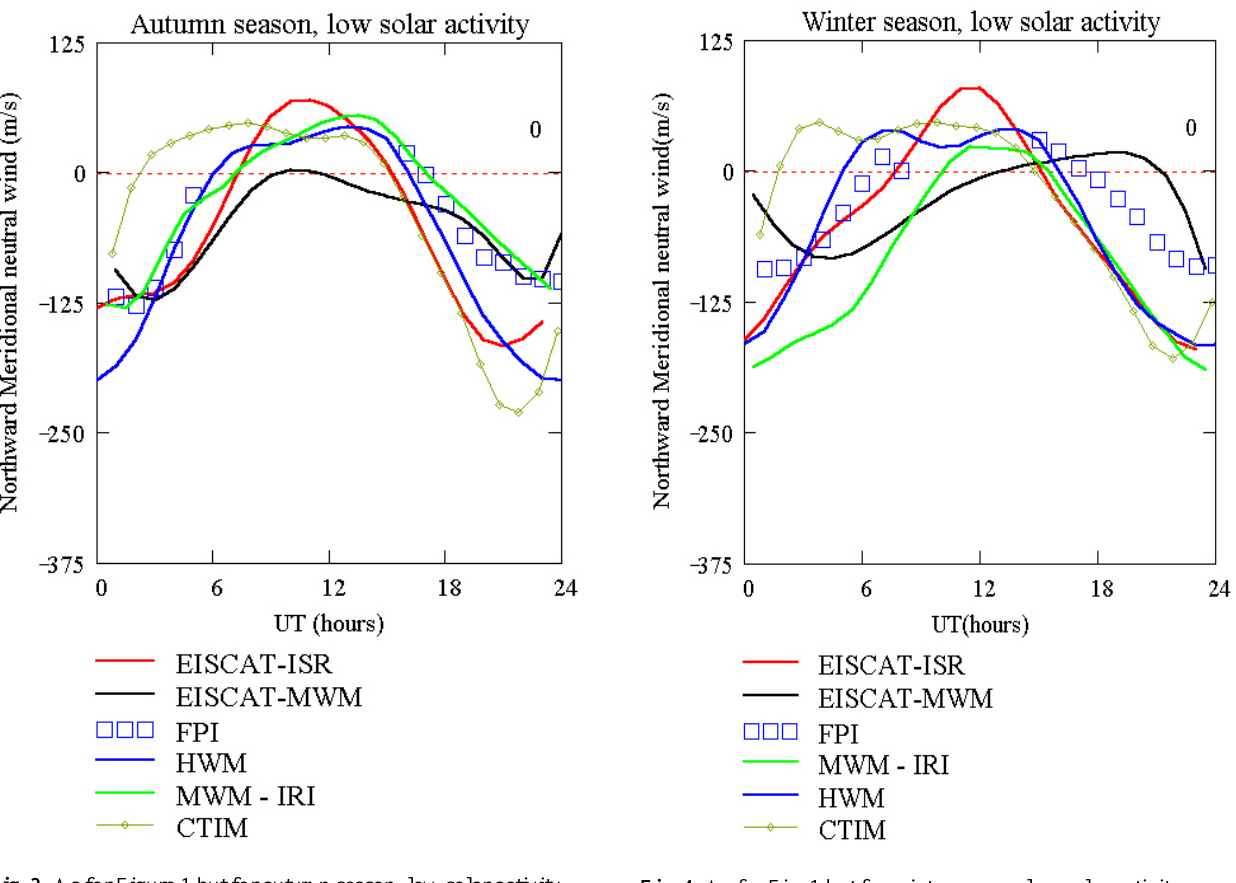
Fig. 4. As for Fig. 1 but for winter season, low solar activity.